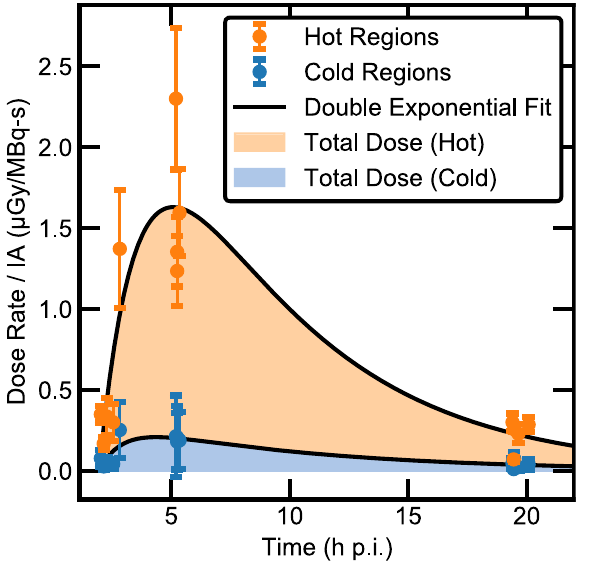
Figure 5. Dose rate curves separated into high-dose-rate (orange, “hot”) and low-dose-rate (blue, “cold”) 2 /ν = 19.5, 2.2 regions. Double-exponential fits ( y = ae − b ( x − m ) − ce − d ( x − n ) , χ for hot and cold, respectively) use data from 14 biopsies across eight canine models, normalized to the injected activity of each study (8.44– 23.2 MBq/kg). Shaded regions show curve-integration to estimate total absorbed dose, yielding hot-region doses of 9 ± 4 Gy and cold-region doses of 1.2 ± 0.8 Gy.